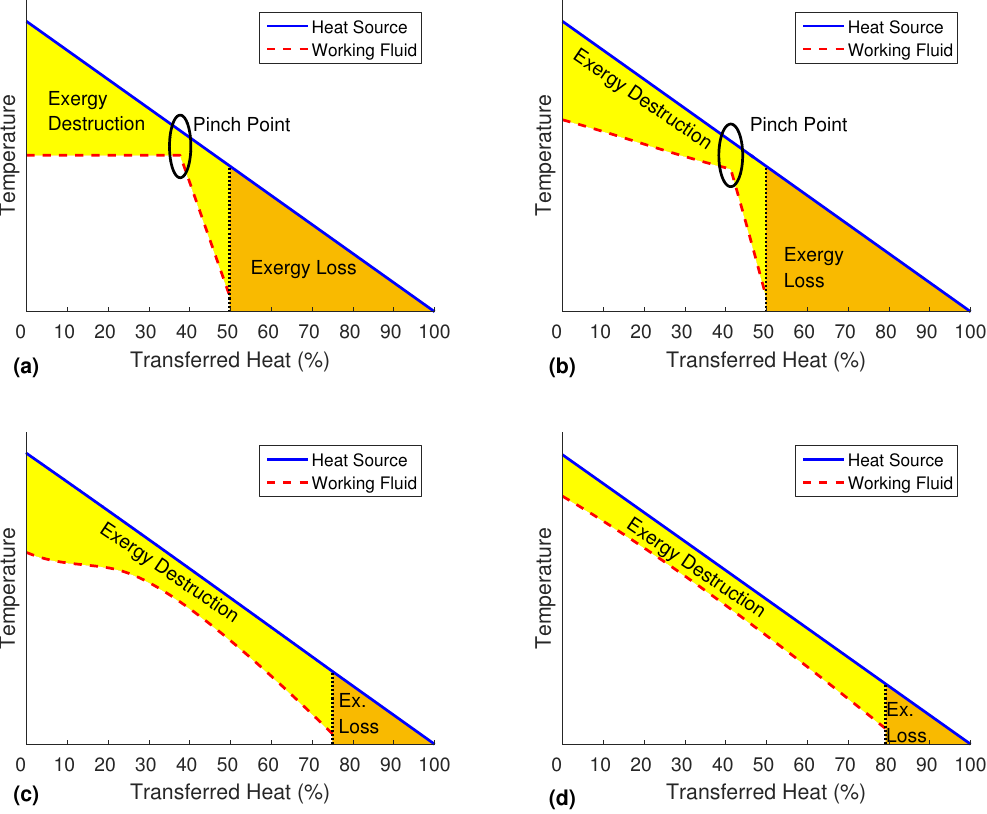
Figure 1. Qualitative comparison of the temperature match in different power cycles: ( a ) common Organic Rankine Cycle (ORC); ( b ) zeotropic cycle; ( c ) supercritical cycle; ( d ) flash